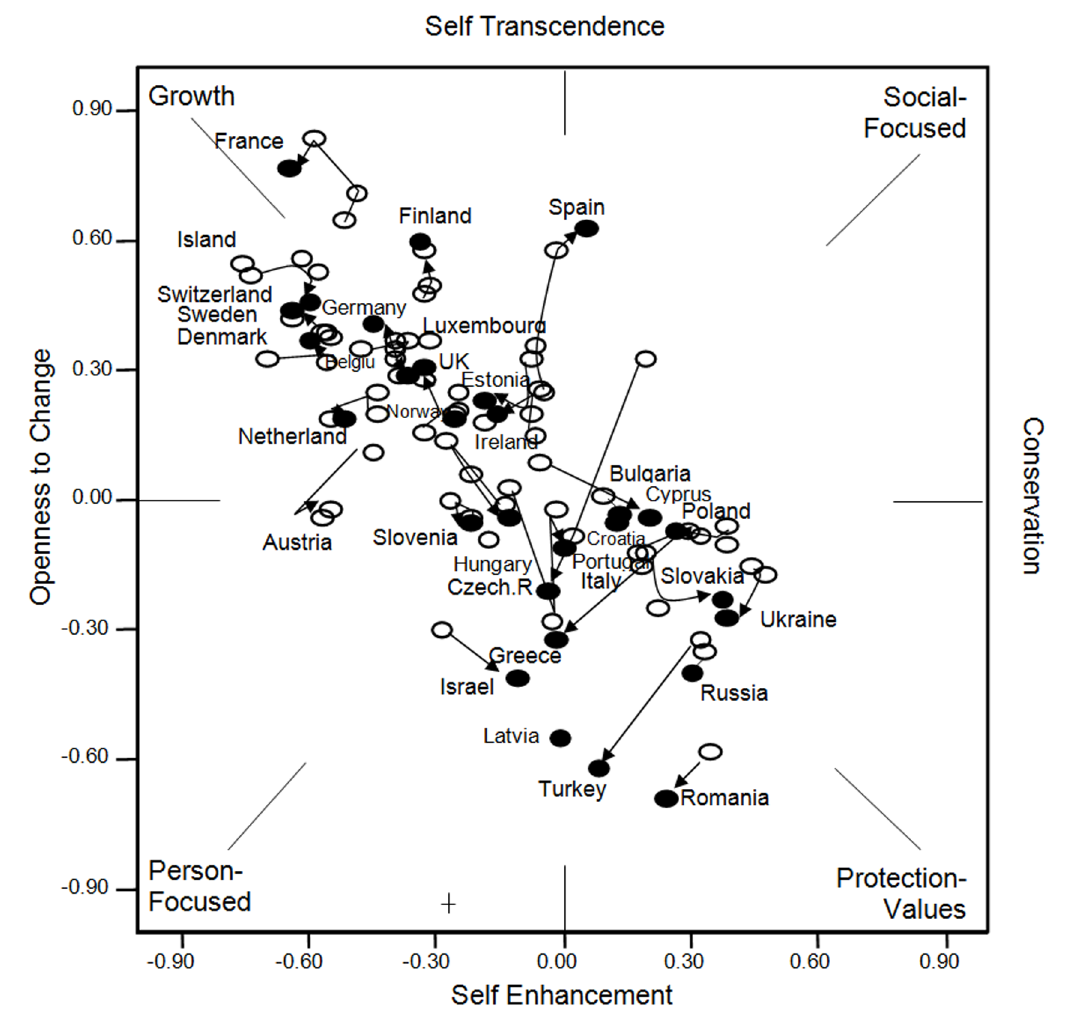
Figure 3. Location of the mean member of a sample in the value circle. Mean values per sample; axes from Figure 2; 98 samples from 33 countries; filled markers indicate ESS round 4, year